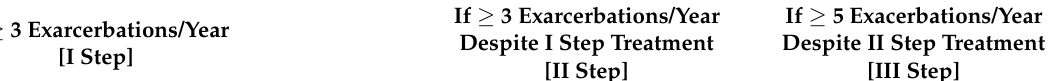
Table 3. Management of chronic infection: pharmacological